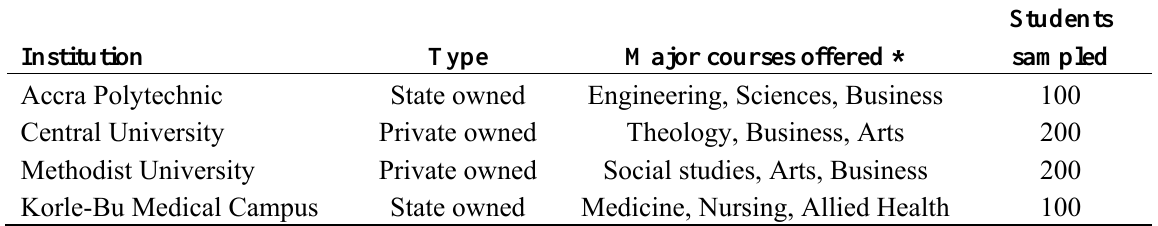
Table 1. Background information of tertiary institutions where the study sampling was done.